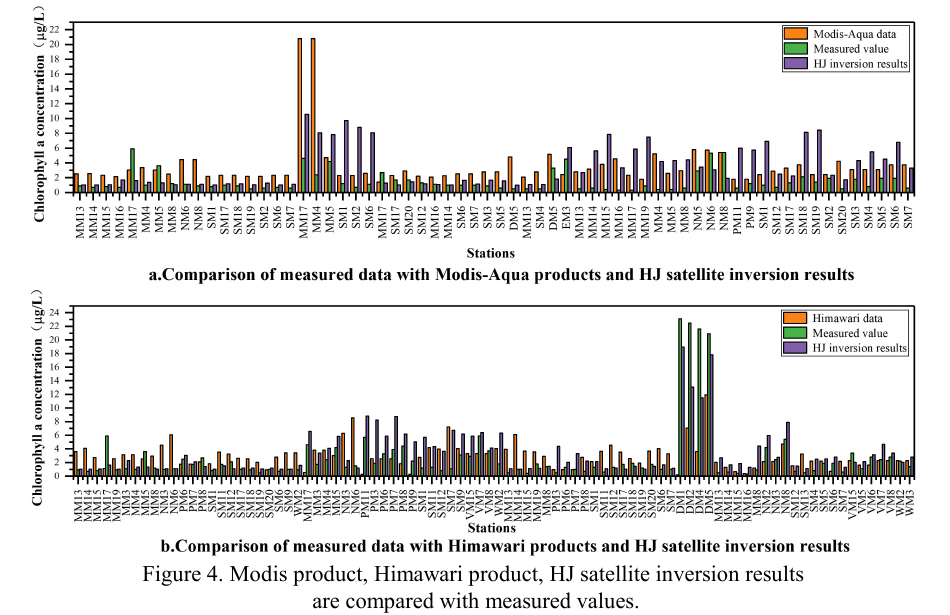
Figure 4. Modis product, Himawari product, HJ satellite inversion results are compared with measured